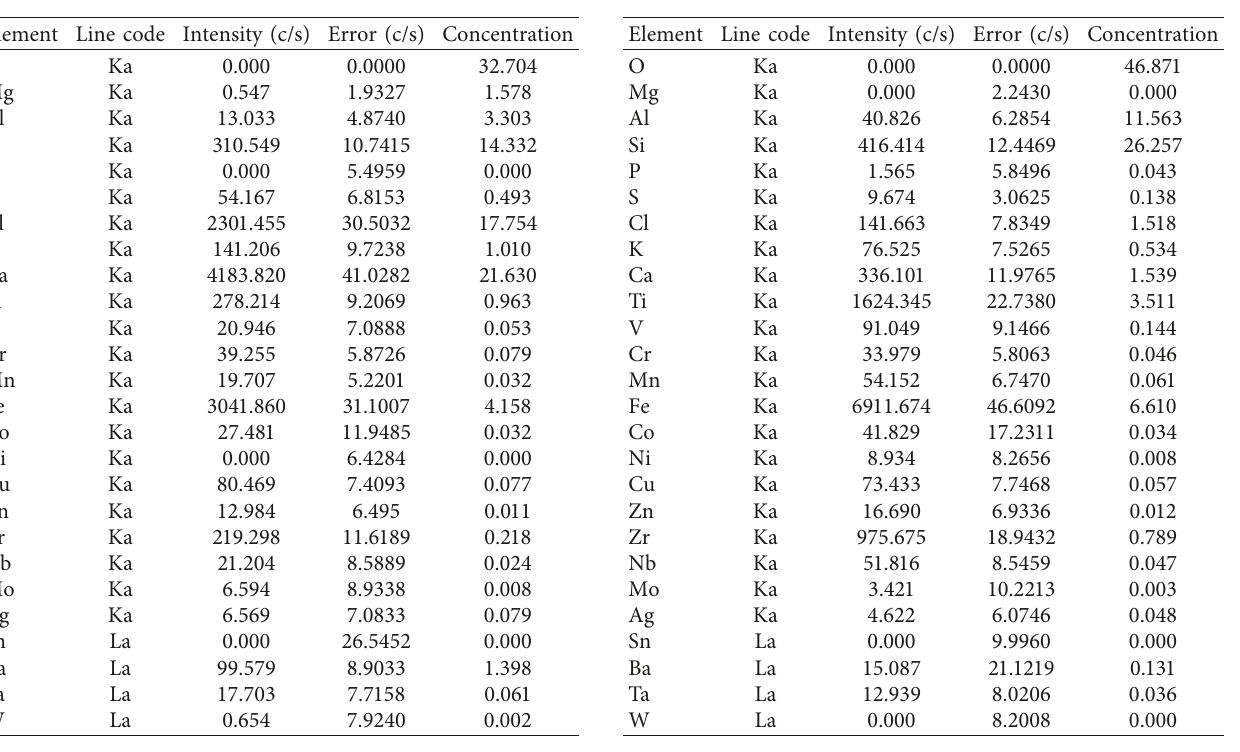
Table 7: XRF element result for natural soil characterization.